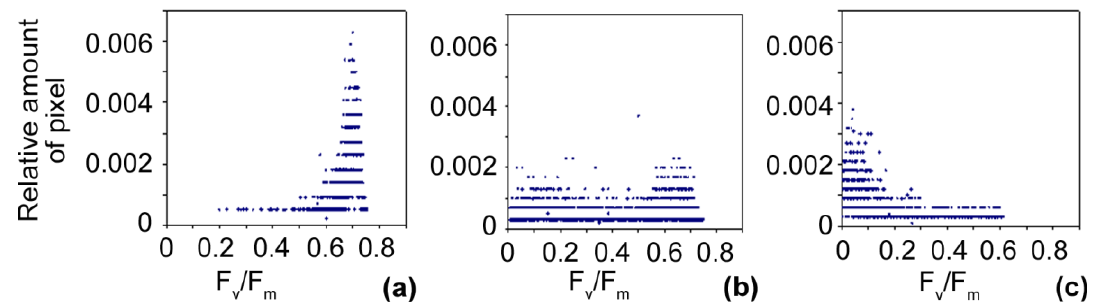
Figure 1. Pixelwise distribution of the maximum photochemical efficiency (F weakly (2%), (b) medium (50%) and (c) strongly infected (90%) wheat ears.